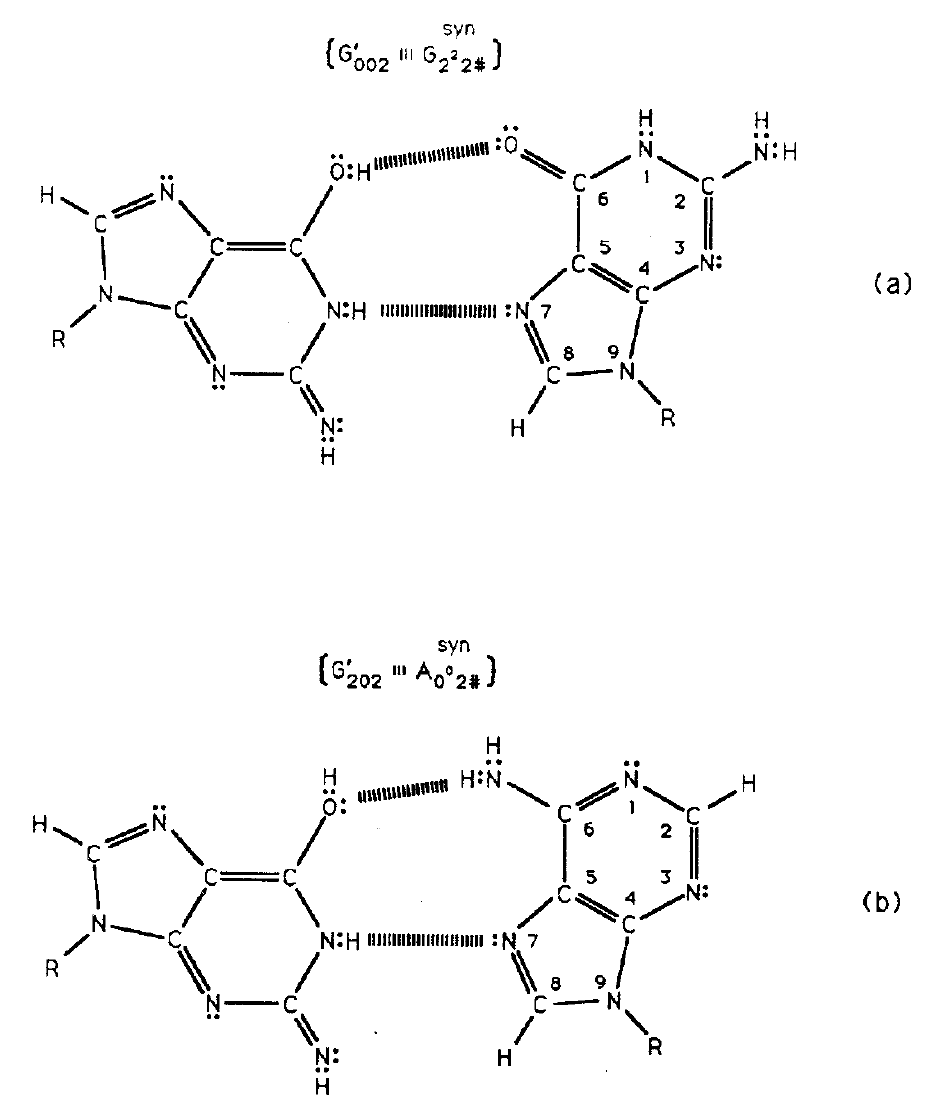
Figure 5. Complementary mispairs between (a) enol-imine G′002 (Figure 2b) and syn-guanine (syn-G2 2 2#) and (b) enol-imine G′202 (Figure 2c) and syn-adenine (syn-A0 0 2#). The # symbol indicates the position is occupied by ordinary hydrogen unsuitable for hydrogen